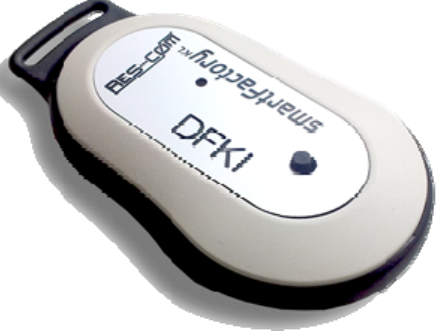
Figure 8. The intelligent sample product: the